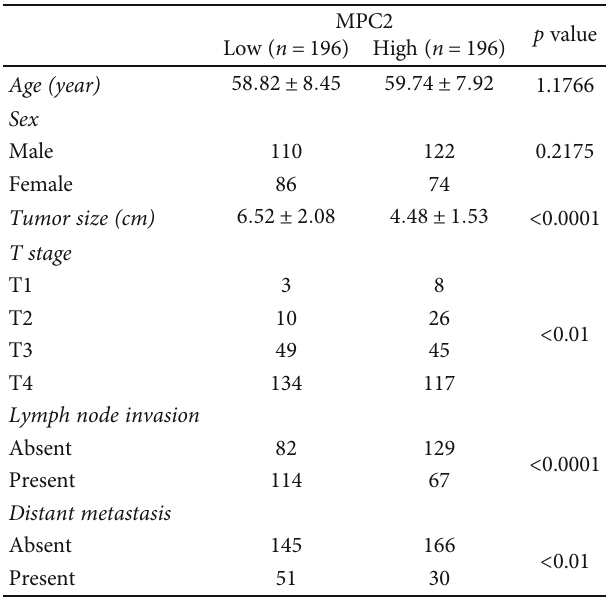
Table 1: Correlation of MPC2 expression with CRC patients ’ clinicopathological